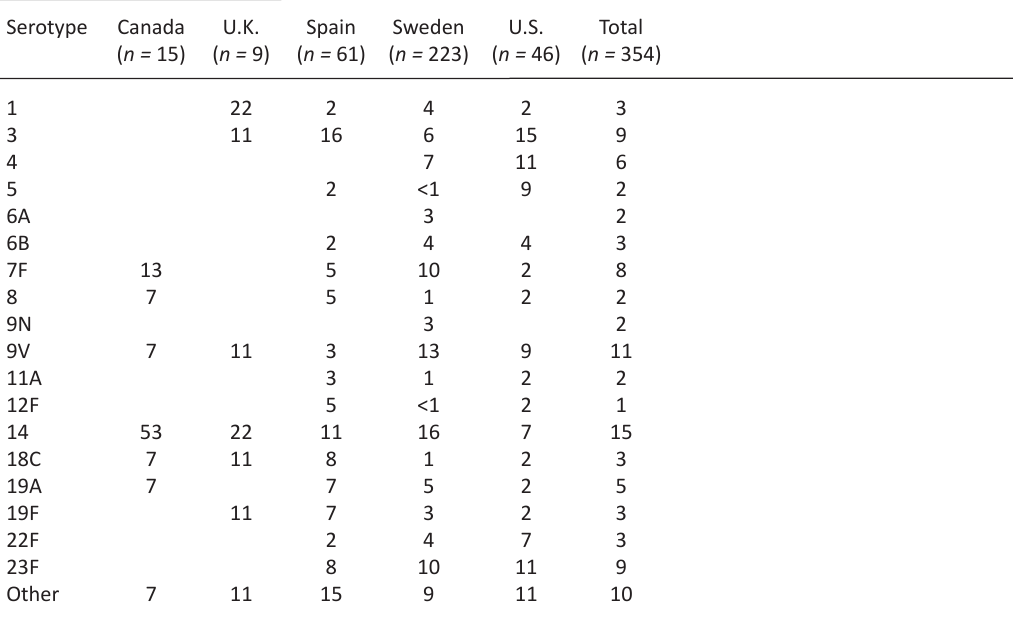
Table 1. Serotype distribution in different countries 4